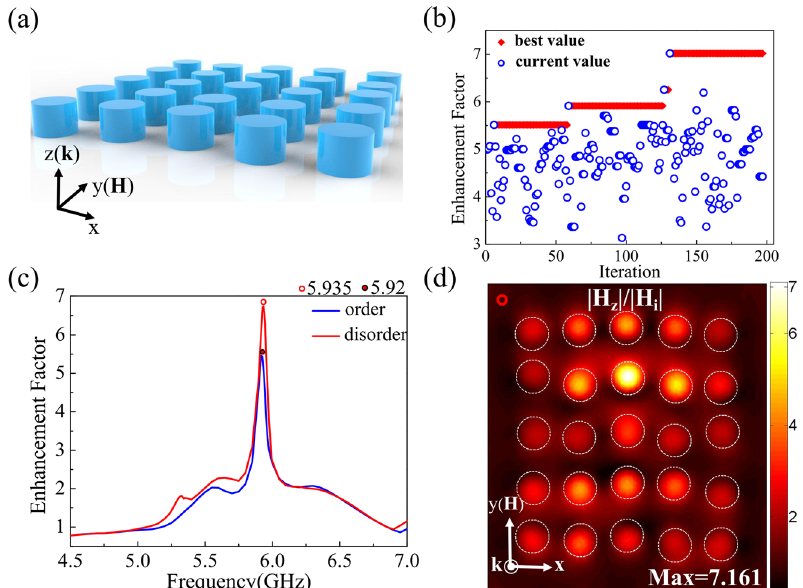
We further consider a different excitation scenario indicated in Figure 3(a) where the disordered structure is optimized to enhance magnetic fi eld along the propaga- tion direction of the plane wave. As can be seen from Figure 3(b), the proposed method can indeed avoid local optimum. The largest enhance factor is 7.16 which is smaller than the case shown in Figure 2 since the magnetic fi eld along the propagation direction is indirectly induced by the electromagnetic near- fi eld interaction, as can be